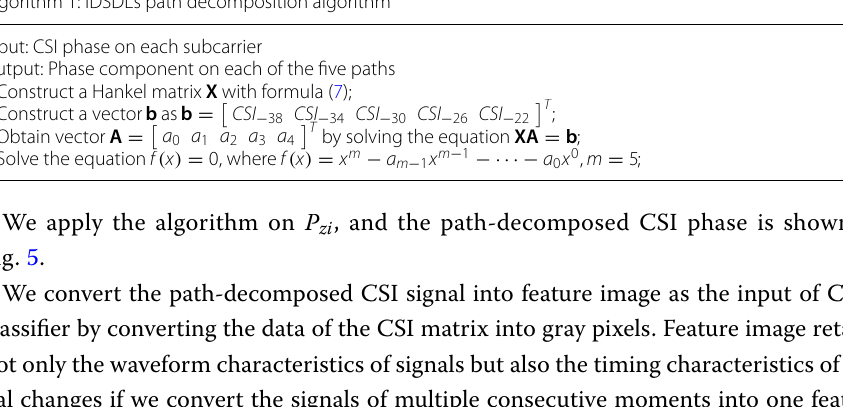
Algorithm 1: IDSDL’s path decomposition